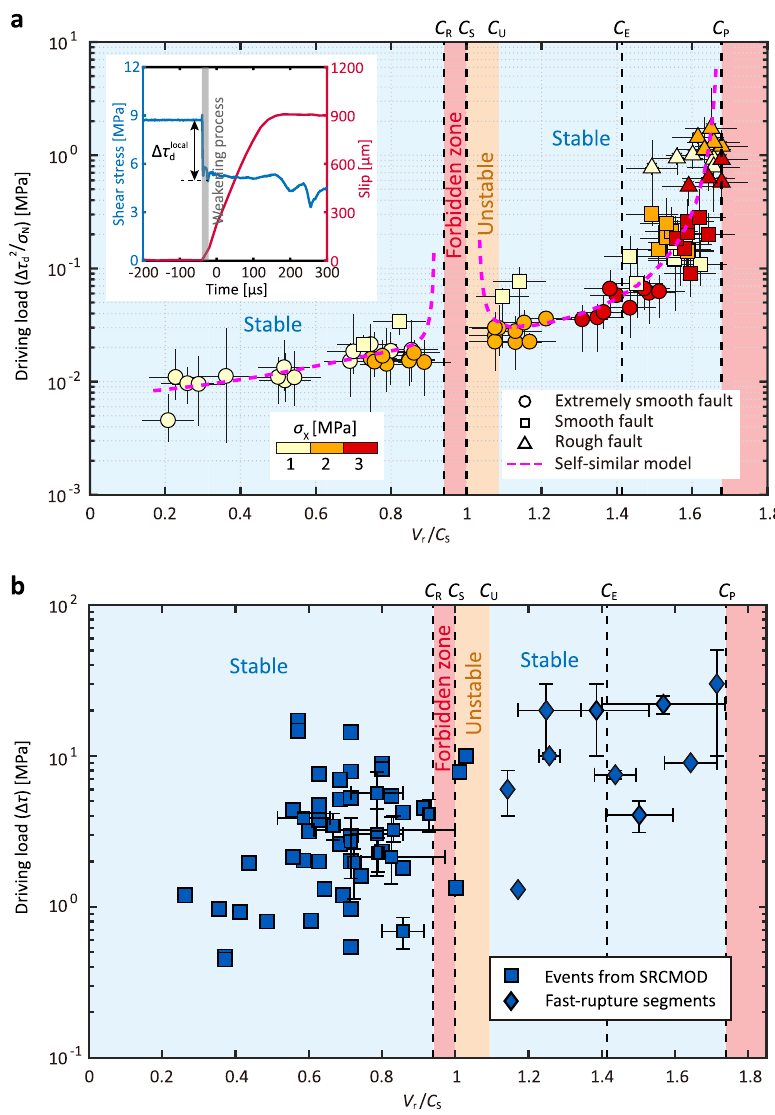
Fig. 4 | Rupture speed versus driving load. a Normalized rupturespeed V r = C S of = σ laboratoryearthquakesasafunctionofthedrivingload 4 τ 2 N withspeedstability d regions revised. The inset shows the de fi nition of the local dynamic stress drop 4 τ local , with the gray strip delineating the transient weakening process. Rupture d events on extremely smooth, smooth, and rough faults are represented by circles, squares, and triangles, respectively. The color of the symbol is coded by the hor- izontalstress σ X .Horizontalbarindicatestherangeofrupturevelocity.Verticalbar indicates the range of driving load calculated from not perfectly uniform local dynamicstressdrop 4 τ local d